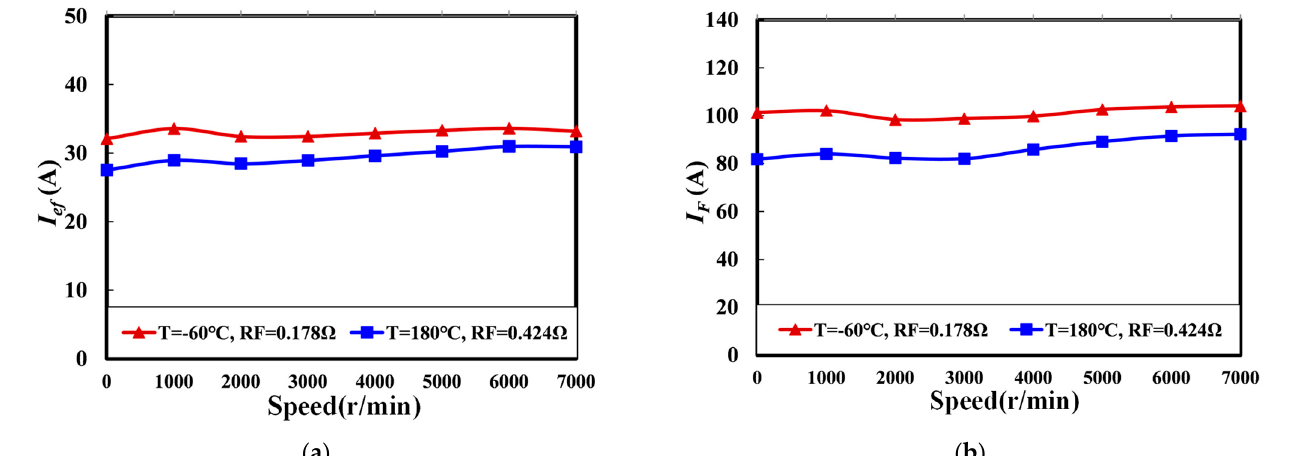
Figure 11. The curve of I ef and I F changing with rotating speed under − 60 °C and 180 °C: ( a ) the curve of exciting current I ef ; ( b ) the curve of exciting current I F .